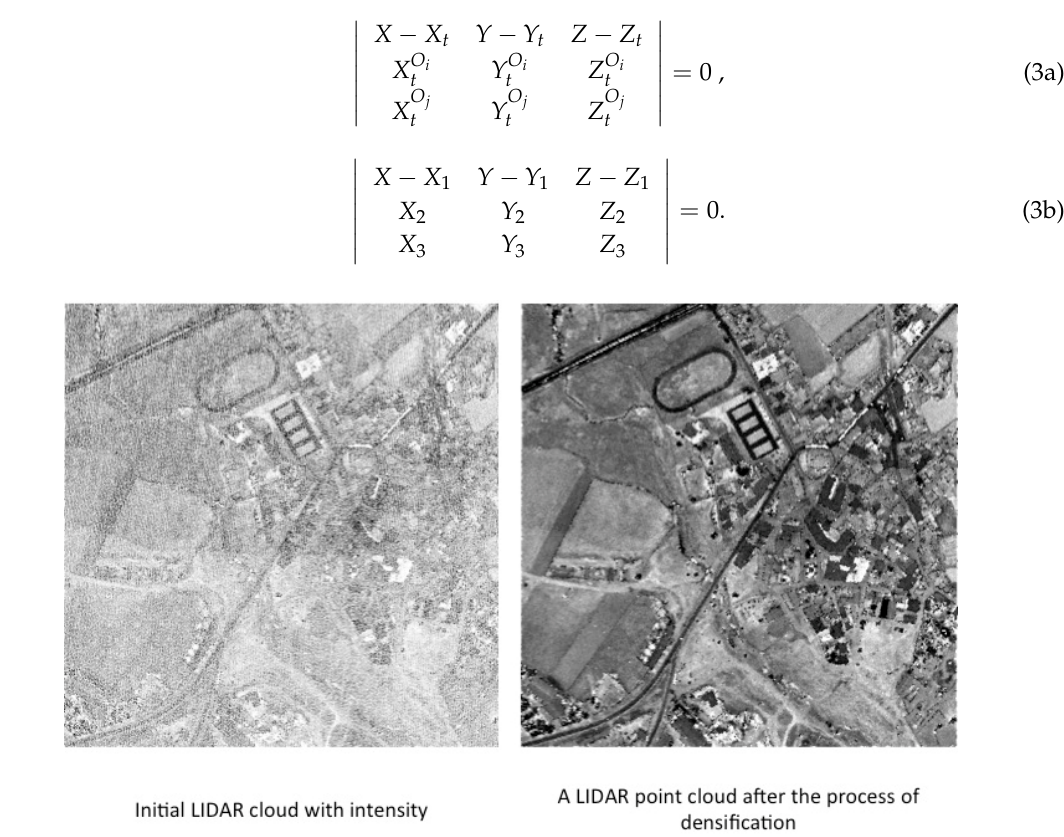
Figure 3. LiDAR point cloud before and after the densification process is completed.